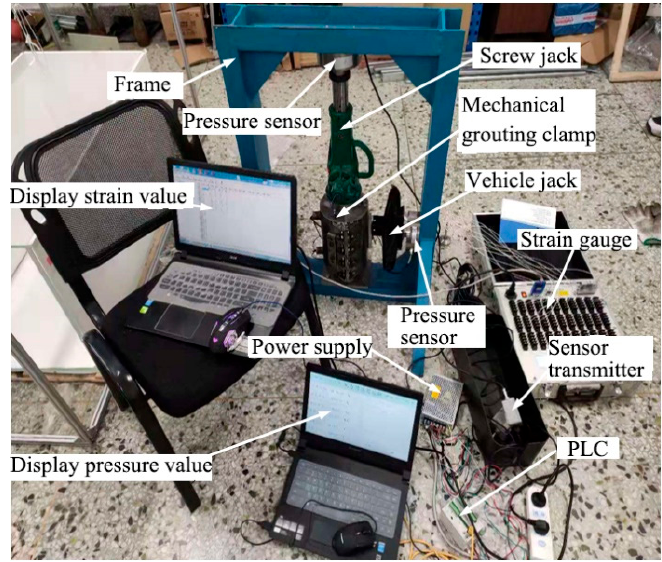
Figure 16. The experimental device.